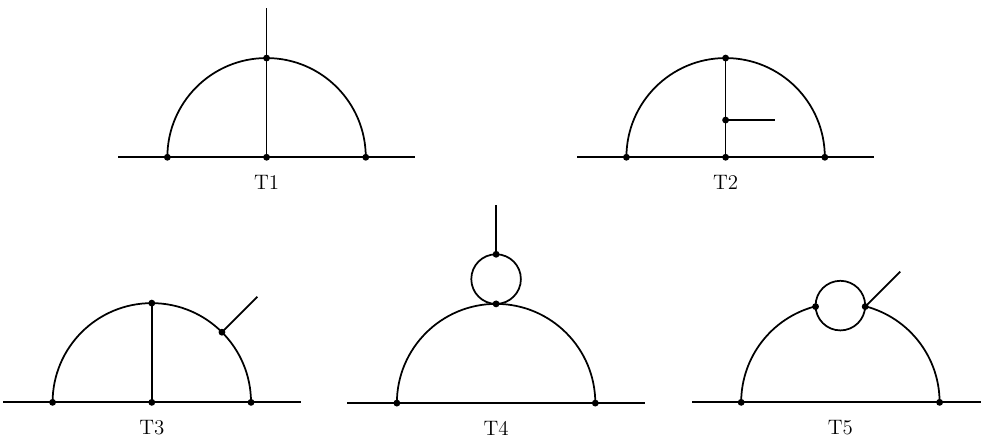
Figure 1 . Finite two-loops 1PI topologies with 3- and 4-point vertices and three external lines. T 1 and T 2 generate in general genuine models. Topologies T 3, T 4 and T 5 are a special kind of genuine topologies, diagrams generated from them are (cid:12)nite but contain a 3-point or 4-point renormalizable vertex which can be in principle reducible, generating a lower order contribution. See the text for